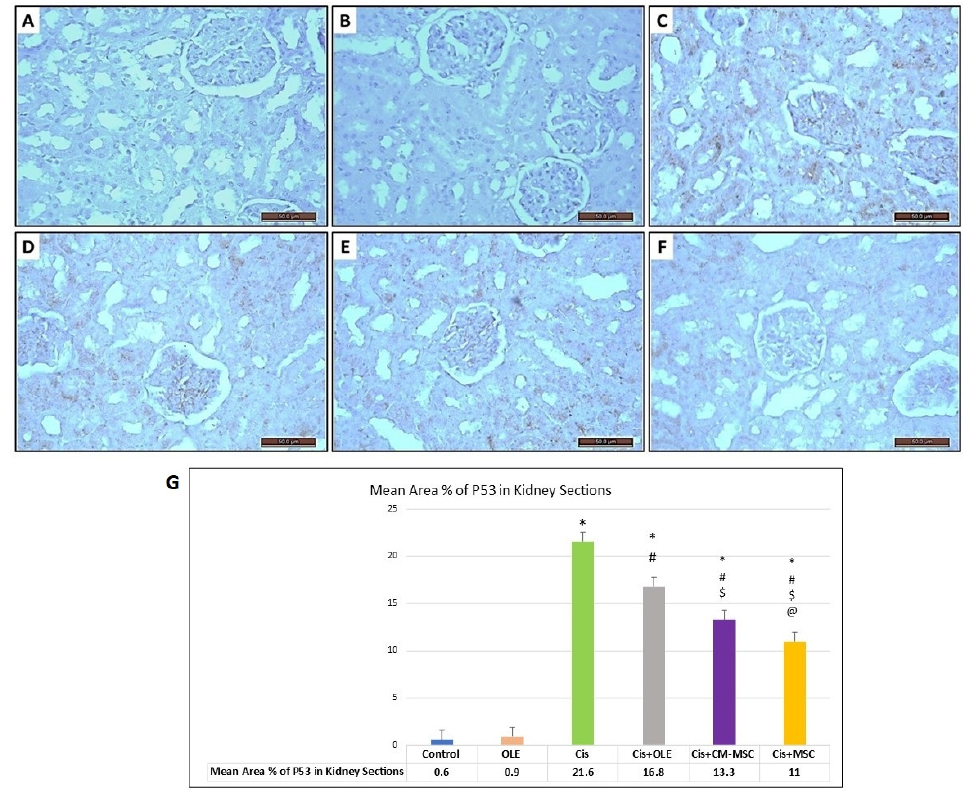
Figure 8. Photomicrographs of anti P53 immunohistochemically stained renal sections of all study groups. Control ( A ) and OLE ( B ) groups showed almost no expression of P53 antibody. Cis group ( C ) showed apparent increase of P53 expression in comparison to Cis + OLE ( D ) and Cis + CM-MSC ( E ) groups. The positive expression was mainly observed in the tubular epithelium and in some few glomerulus cells. Minimal expression was observed in Cis + MSC group ( F ). ( G ) The mean area percentage bar chart of P53 positively stained cells in the sections of the kidney. Mean ± SD was used to express the data of the experiment. 6 fields per section/rat. Significant in comparison to control group (*), Cis group (#), Cis + OLE group ($), and Cis + CM-MSC group (@); ( p < 0.05). 3.10. Histopathological and Immunohistochemical Assessment of Thymus Sections H/E-stained sections of the thymus were examined histologically to assess the effect of the different administered treatments. Control and OLE groups showed normal struc- ture of the thymus, which is composed of cortex and medulla. The cortex is more heavily populated with T-lymphocytes than the medulla, which appeared paler than cortex. In the medulla, Hassall’s corpuscle was identified (Figures 9A,B and 10A,B). Cisplatin group showed marked decrease in lymphocytes density in the cortex and medulla. In addition, there was an increased number of Hassal’s corpuscles in the medulla. There were empty spaces in the medulla (Figures 9C and 10C). Cis + OLE, Cis + CM-MSC, and Cis + MSC groups showed restoration of the normal histological structure of the thymus (Figures 9D–F and 10D–F).